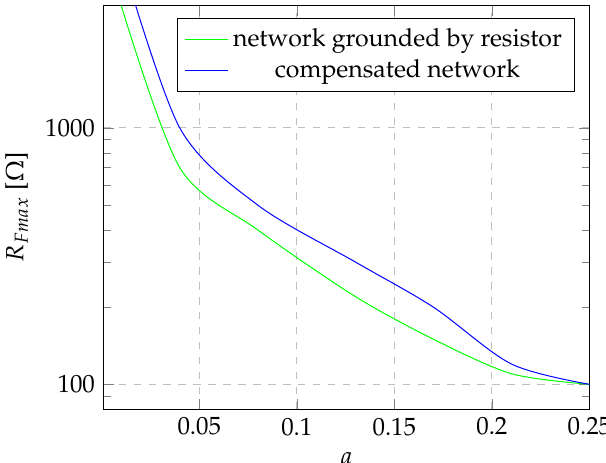
Figure 4. Maximum values of R F , the occurrence of which causes the tripping of the classic zero- sequence current criterion in the network with the neutral point grounded by a resistor and the compensated network with the given parameters.